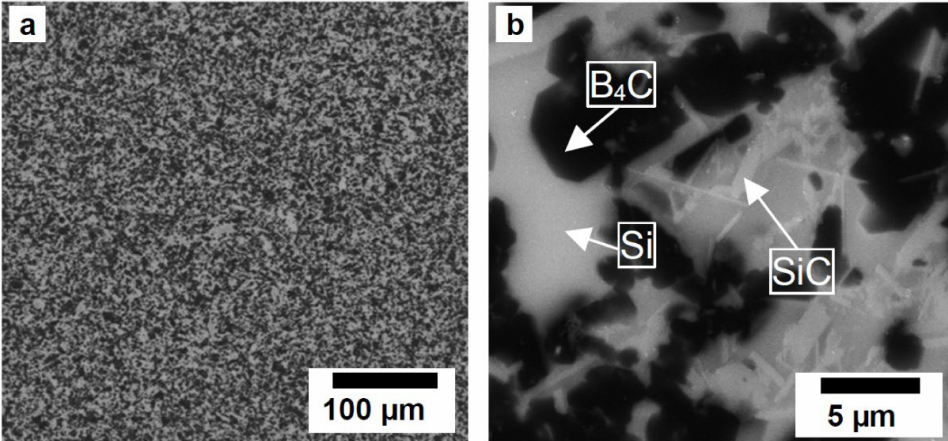
Figure 1. ( a ) Representative SEM images of a siliconized B 4 C-based sample with an initial binder content of 18.6 vol.%. ( b ) Higher magnified SEM image with detected phases: B 4 C, reaction-formed SiC, and Si.